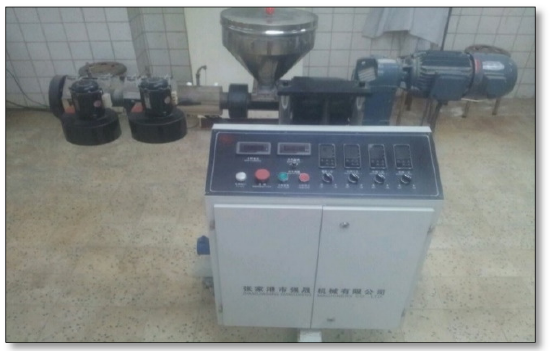
Fig. 1. Single screw extruder equipment (SJ30 / 28). Fig. 2a. Schematic diagram of the extruder.